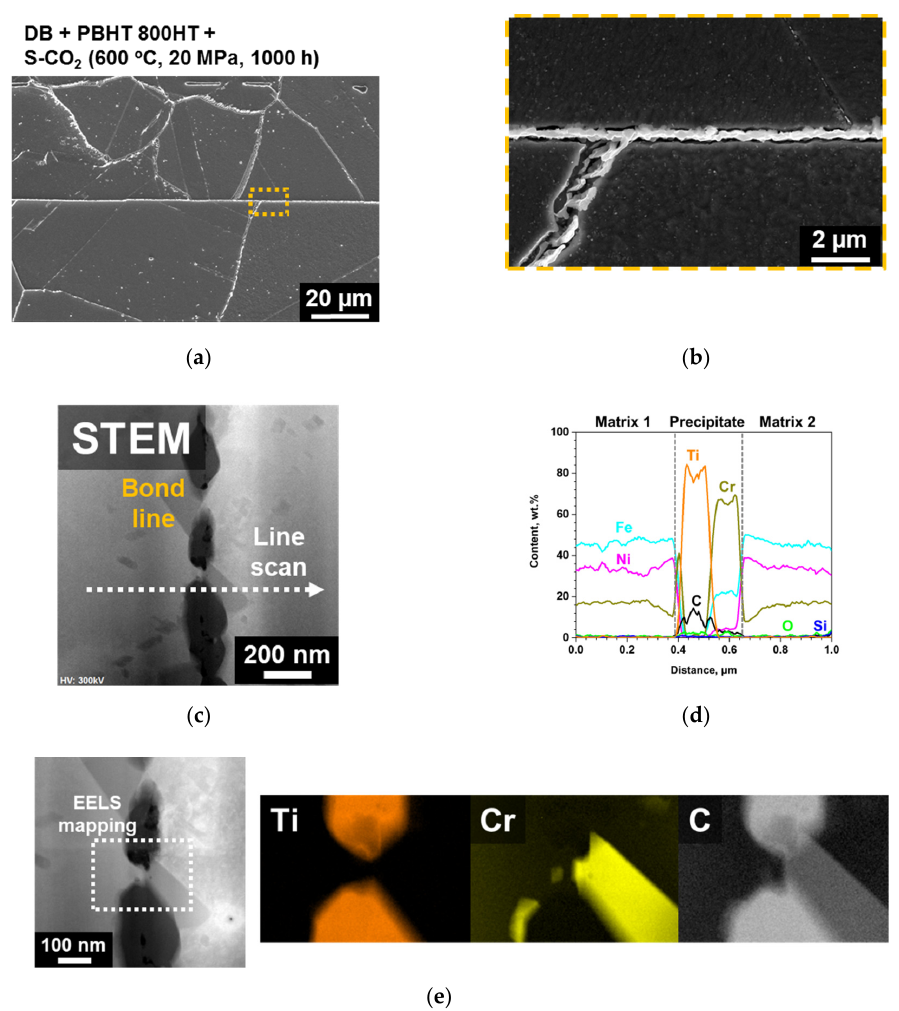
Figure 9. SEM analyses results of PBHT ‐ ed Alloy 800HT at the bond ‐ line after S ‐ CO 2 exposure at 600 °C (20 MPa) for 1000 h; ( a ) Low magnification, ( b ) high magnification of the box in ( a ), and TEM analysis results; ( c ) STEM micrograph, ( d ) EDS line scanning and ( e ) EELS mapping image of